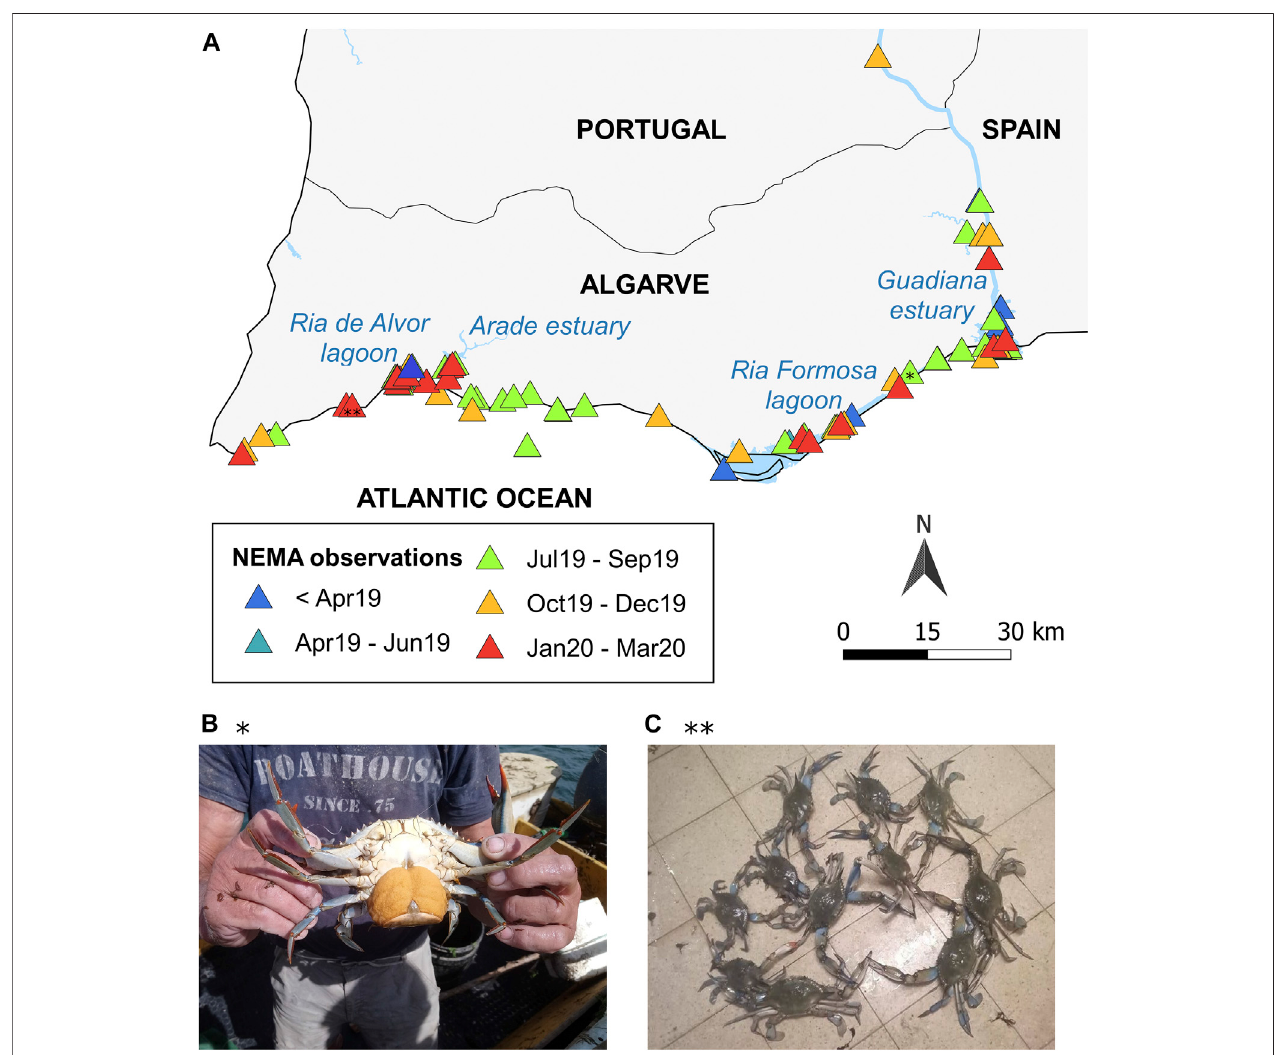
FIGURE5|(A) ObservationsdocumentingtheexpansionoftheAtlanticbluecrabfromEasttoWesternAlgarveuntiltheendofMarch2020.Informationsubmitted byinformedcitizensandcitizenscientiststotheNEMAcitizensciencecampaign.Eachiconrepresentsanobservationthatmayincludemorethanonespecimen. (B) An ovigerous Atlantic blue crab specimen collected in the Ria Formosa lagoon on September 20, 2019 (observation #41 submitted by D. Barragão). (C) Atlantic blue crabs collected off Lagos on January 17, 2019 (observation #70 submitted by V. Gomes). For a detailed list and description of each observation, please see Supplementary Table S2 of the online Supplementary Material. Map generated with QGIS 3.12 Bucuresti (QGIS.org, 2021).